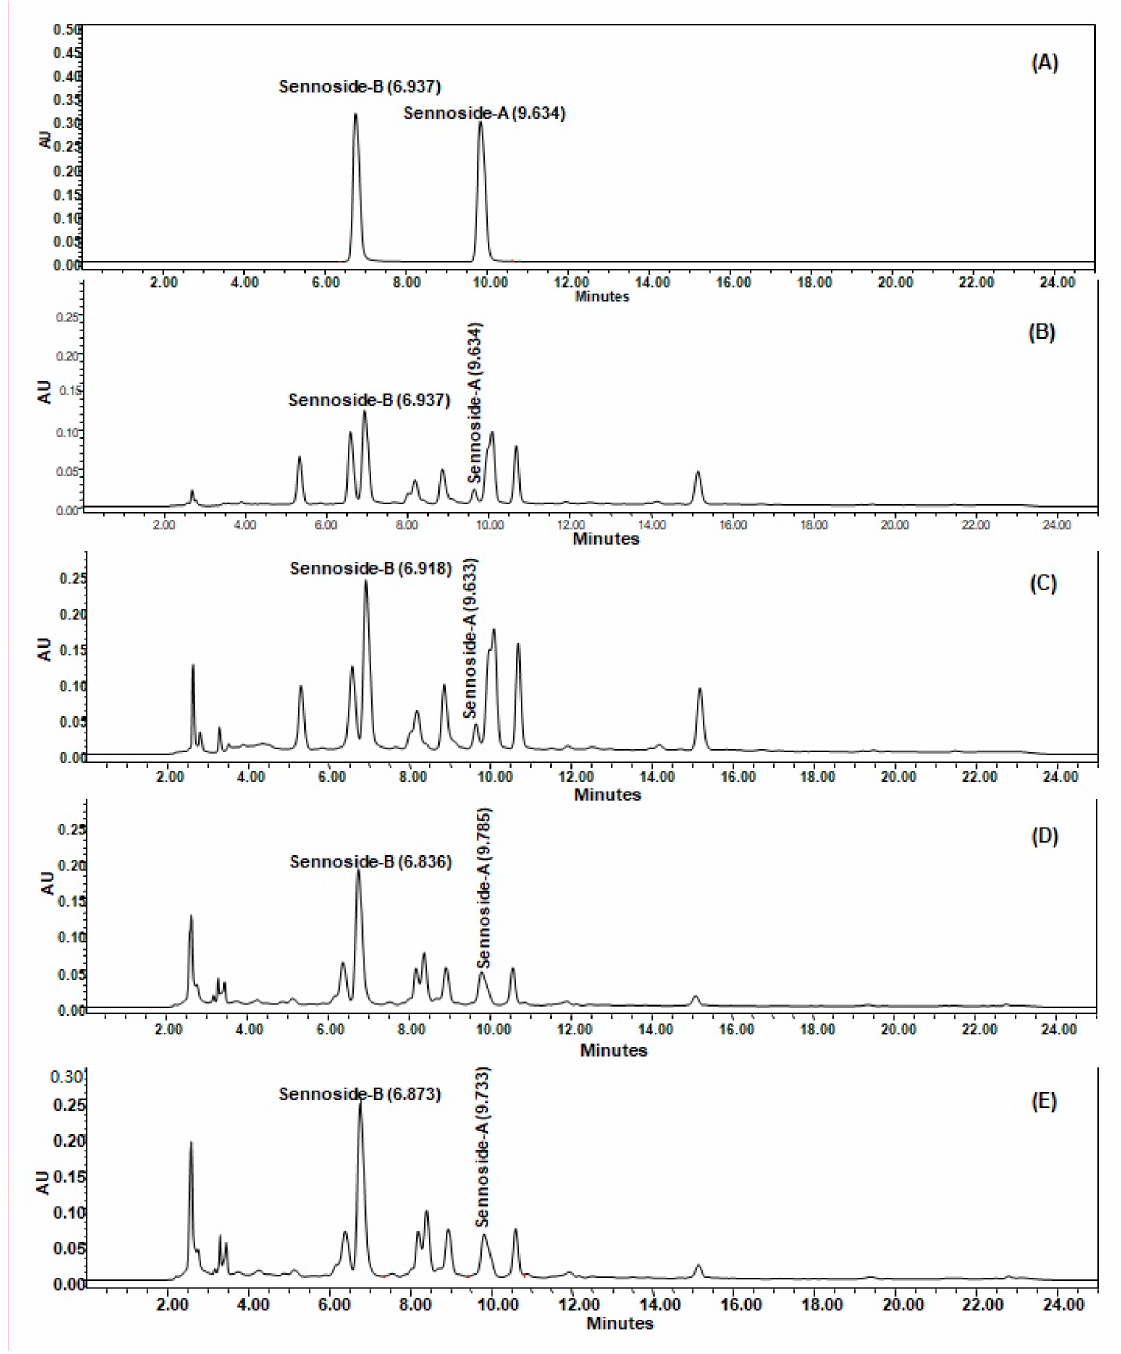
Figure 3. Sennoside A and sennoside B estimation in Senna alexandrina (SA), S. alexandrina with mycorrhizae (SAM), Senna italica (SI) and and S. italica with mycorrhizae (SIM) by HPLC–UV method (conditions: Pinnacle C18 column (4.6 × 250 mm, 5 µ m); mobile phase, acetonitrile: 0.5% formic acid in ultra-pure water (gradient system); flow rate, 1 mL / min; UV detection at λ max = 272 nm at temperature (25 ± 1 ◦ C). ( A ) Representative chromatogram of sennoside B (Rt = 6.937) and sennoside A (Rt = 9.634); ( B ) The retention times (Rt) of sennoside B and sennoside A from SA were 6.937 and 9.634 min, respectively; ( C ) from SAM, they were 6.918 and 9.633 min, respectively; ( D ) from SI, they were 6.836 and 9.785 min, respectively; ( E ) from SIM, they were 6.873 and 9.733 min,